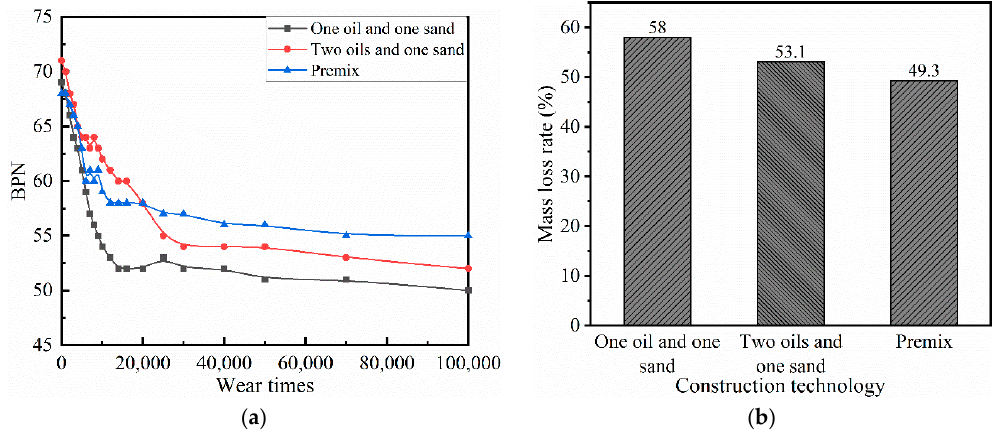
Figure 22. Performance of skid resistance fog seal under different construction techniques: ( a ) skid resistance; ( b ) wear resistance.